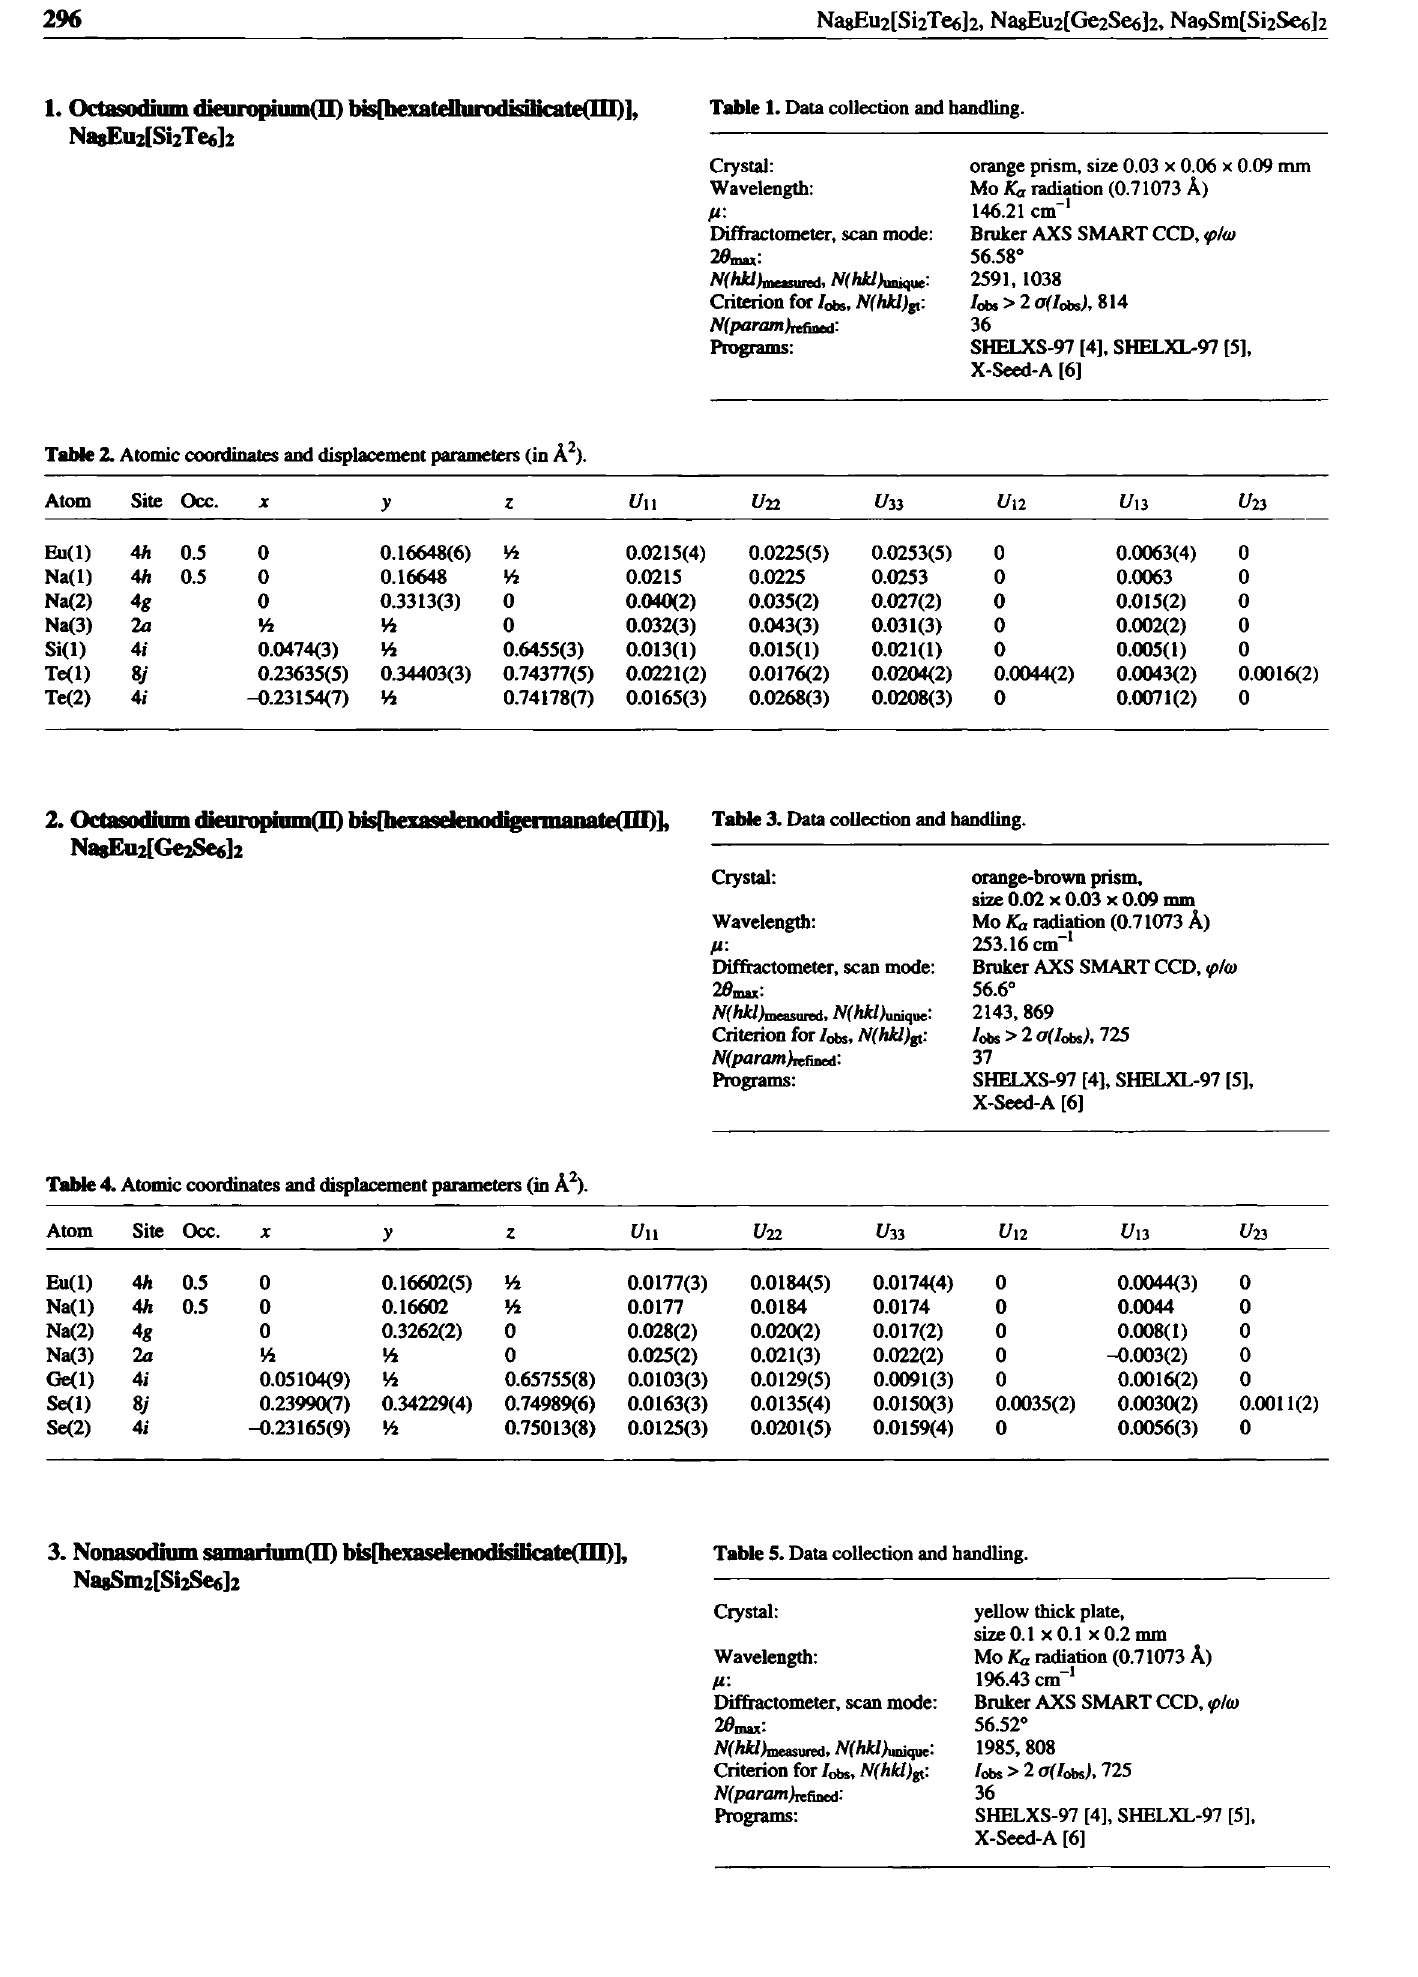
Table 5. Data collection and